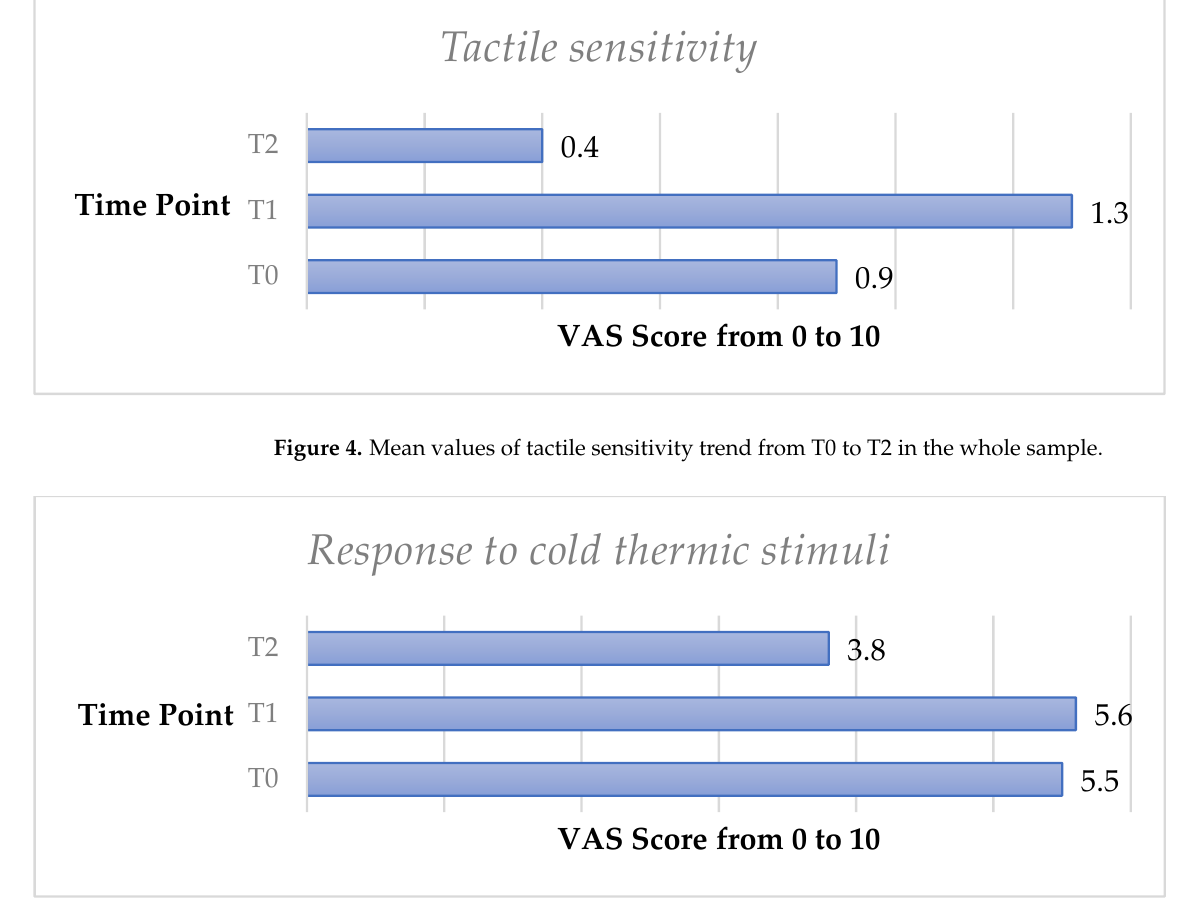
Figure 5. Mean values of thermic sensitivity test trend from T0 to T2 in the whole sample.